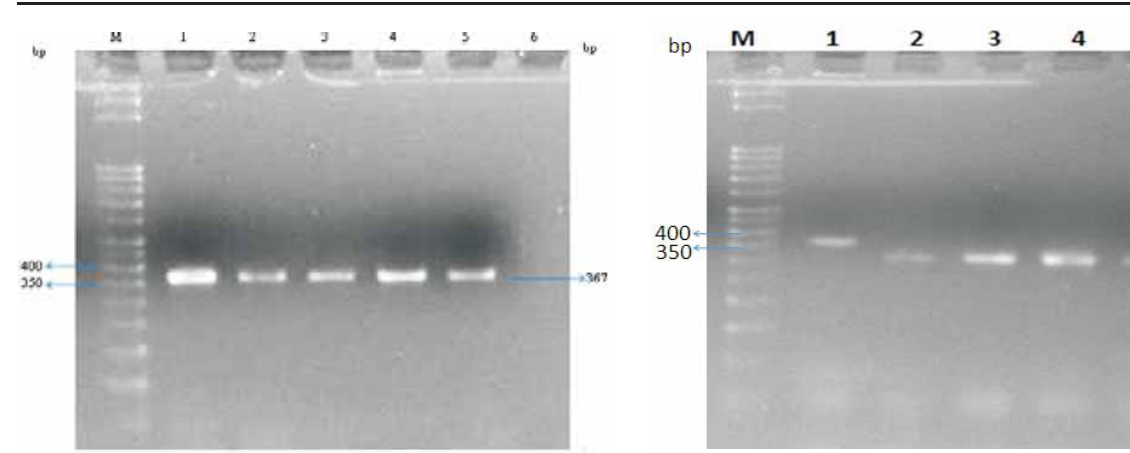
Figure-2: animals.PCR-RFLP of gene fragment by using Lane M: 50 bp DNA ladder, Lane 1: PCR restriction enzyme. product of 367 bp, Lanes 2 to 5: RE digestion product of 313 and 54 bp for normal